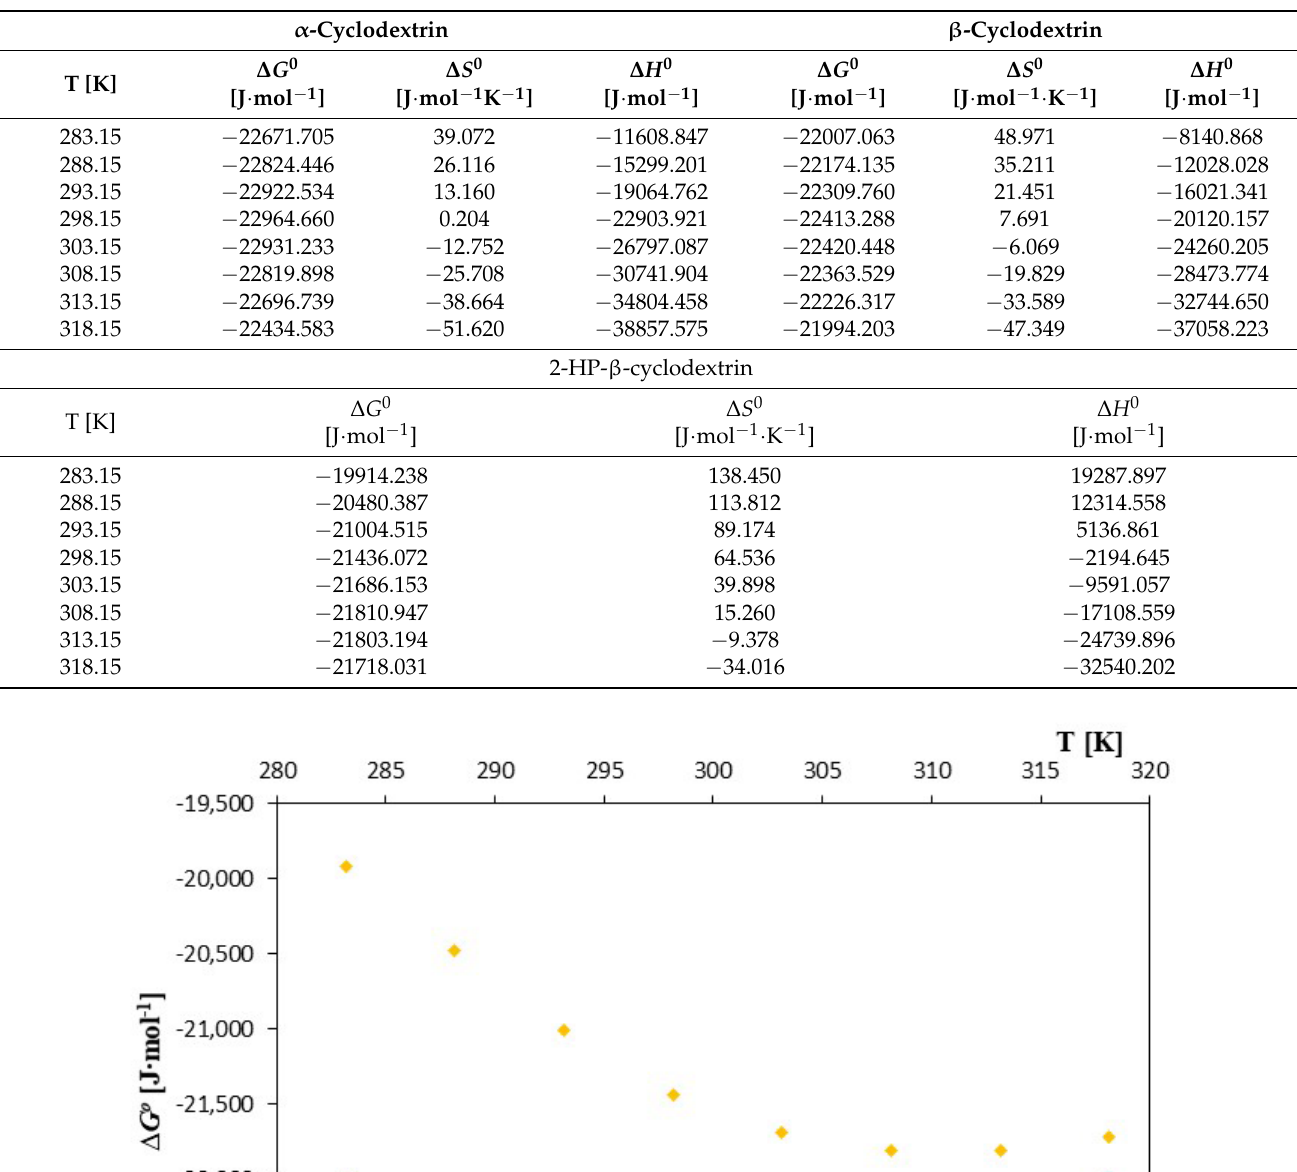
Table 3. The values of thermodynamic functions ∆ G 0 , ∆ S 0 and ∆ H 0 for α -cyclodextrin, β -cyclodextrin and 2-HP- β -cyclodextrin with the salt of dodecanoic acid.